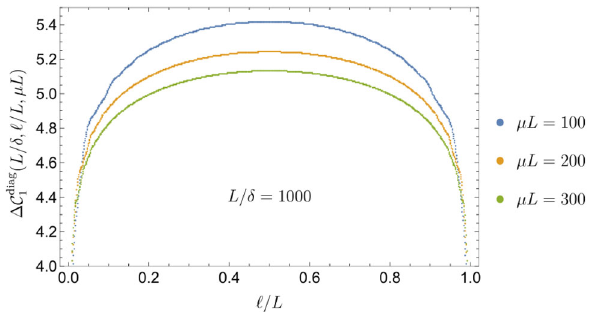
Fig. 15 Mutual complexity of subregions of the vacuum as a function ofthesubregionsize.Thistypicallog ( sin ( # )) behaviorisreminiscentof the Calabrese and Cardy formula for the entanglement entropy. Figure taken from [74]. Here the mass was fixed to be small mL = 0 . 01